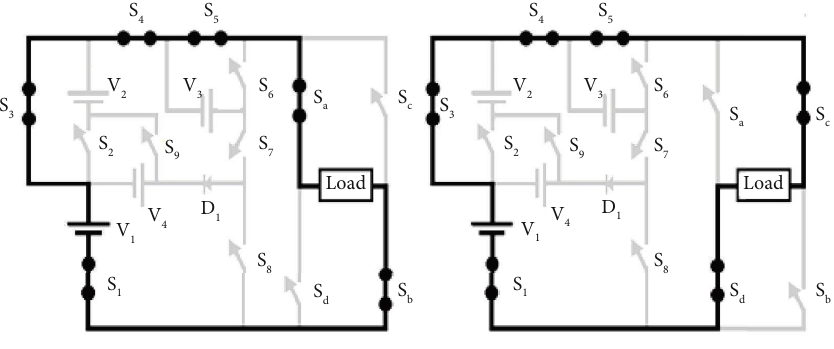
Figure 3: Operating mode: ± V